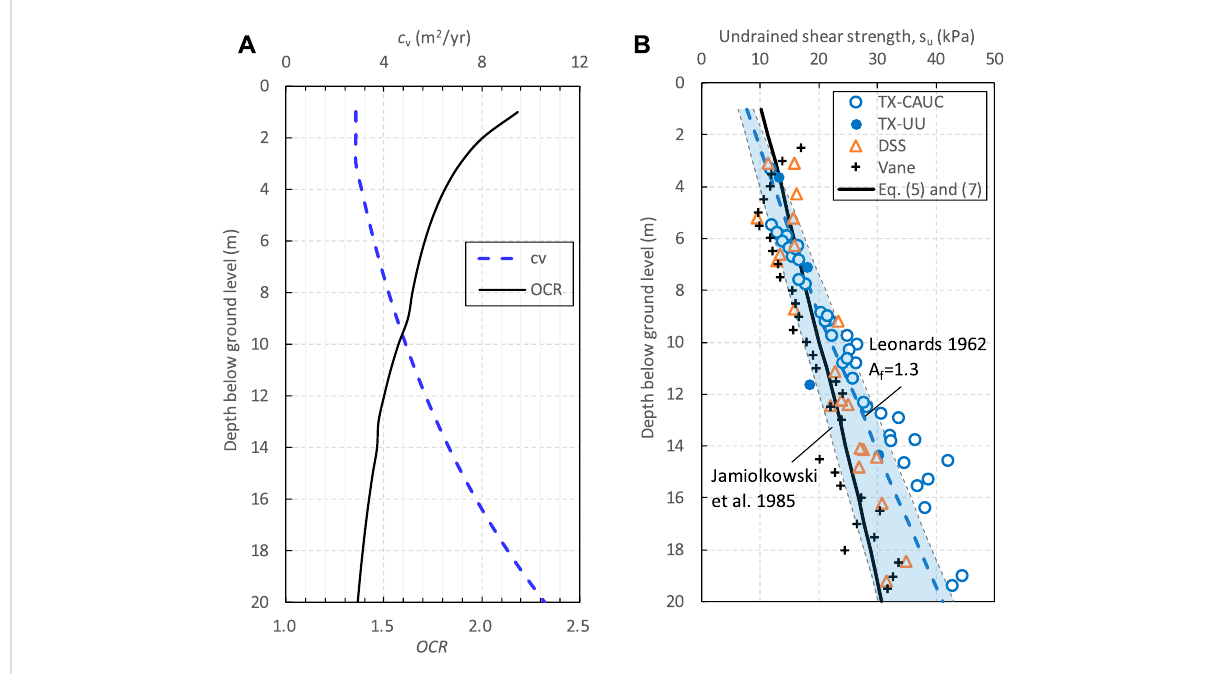
FIGURE 16 Intact Onsoy clay: (A) OCR and c v pro fi les, (B) comparison between predicted and measured undrained